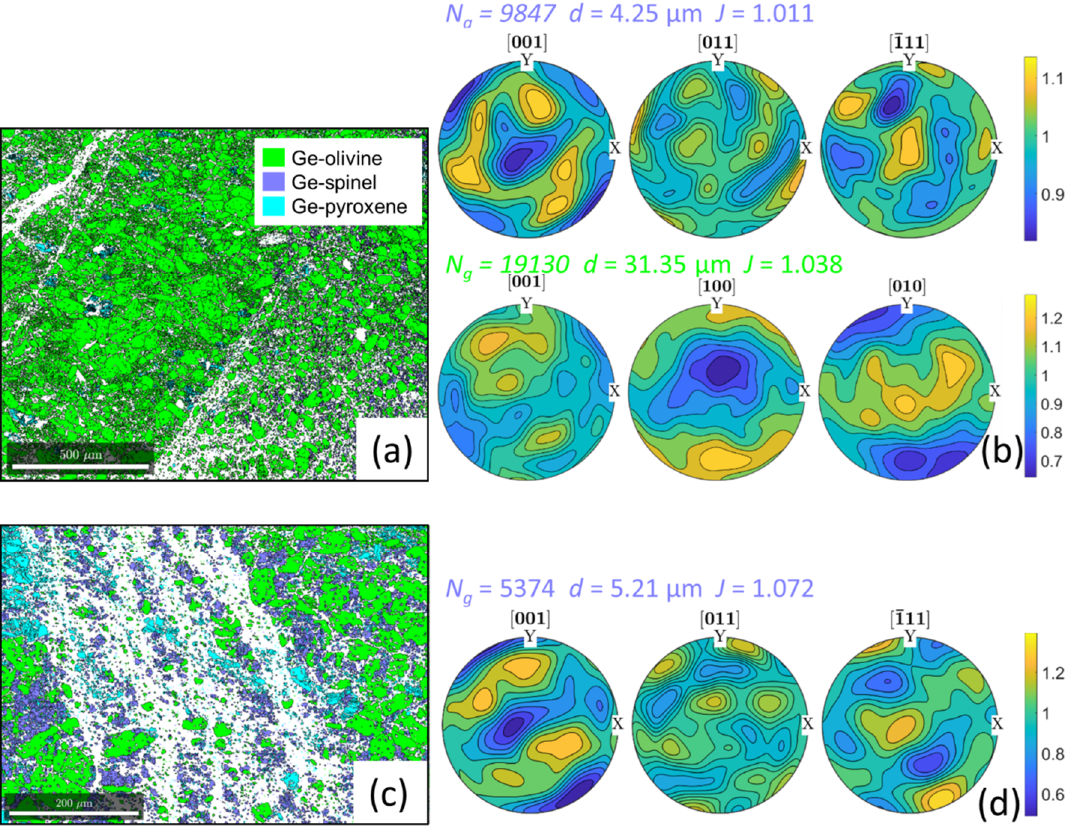
Figure 11. EBSD data collected on samples G16 ( a , b ) and G23 ( c , d ). ( a , c ) show phase maps and calculated grain boundaries (black contours). ( b , d ) show corresponding pole figures for ( a , c ), respectively. Number of grains used, Ng, average grain size, d, and J indexes are given on top. Pole figures are only shown for Ge-spinel in ( d ), as Ge-olivine did not present any identifiable CPO, likely due to a lower number of grains than in ( c ).